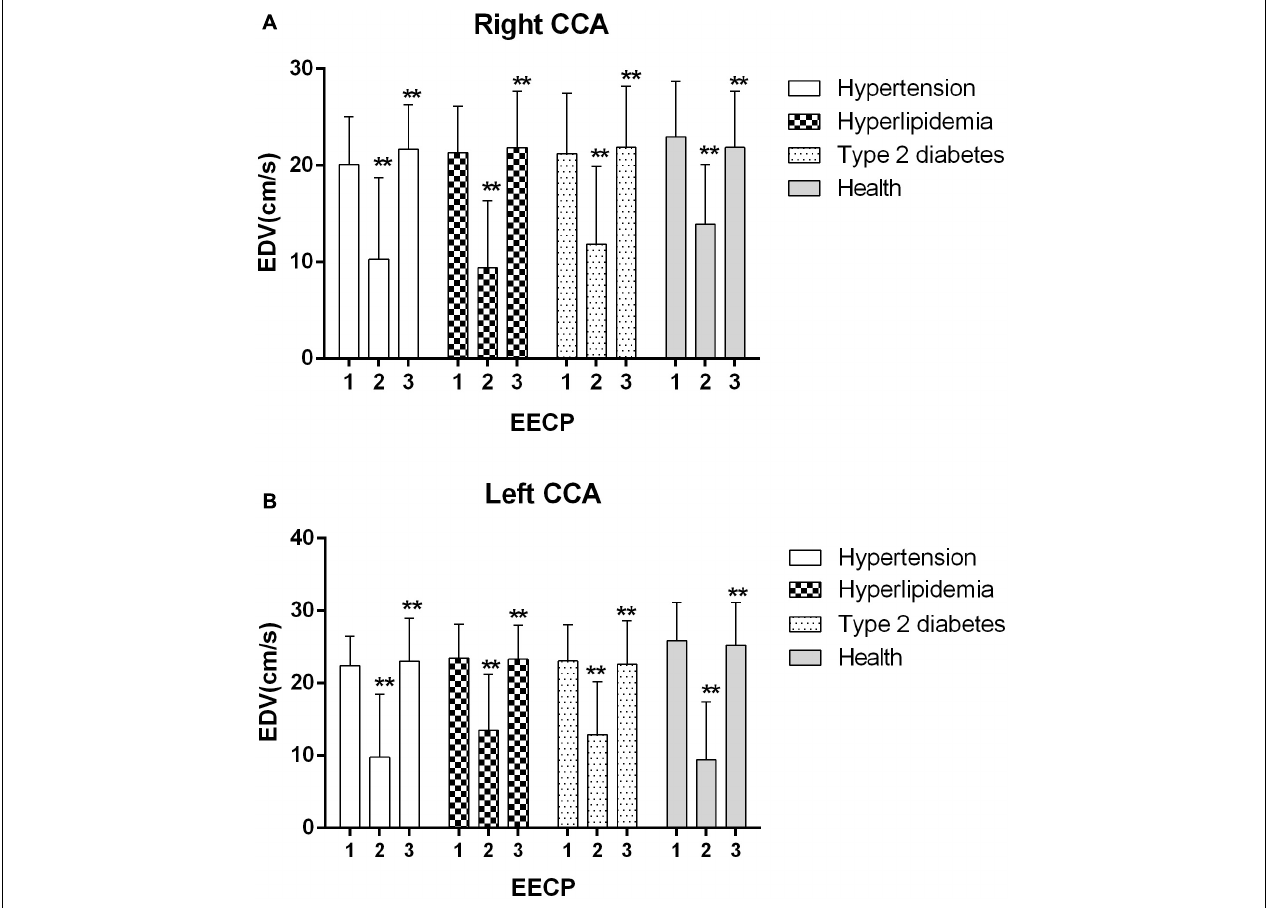
FIGURE 4 | Effect of EECP on the end-diastolic velocity (EDV) of the right (A) and left (B) common carotid artery (CCA) in four groups before, during and after 45-min EECP. ** P < 0.01 during EECP vs. pre-EECP.